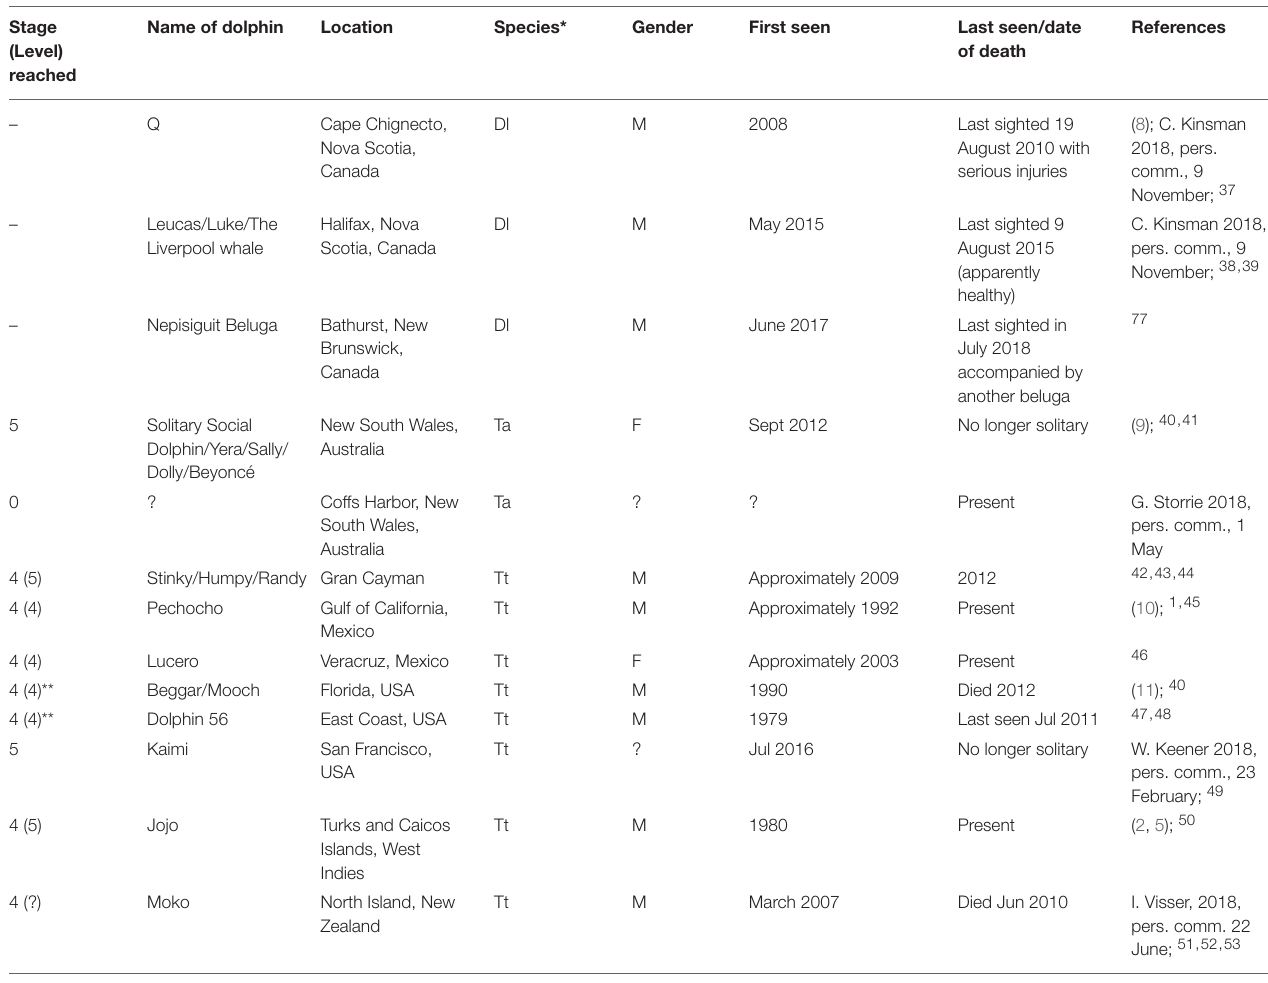
TABLE 3 | Solitary and solitary-sociable dolphins in the Rest of the world since